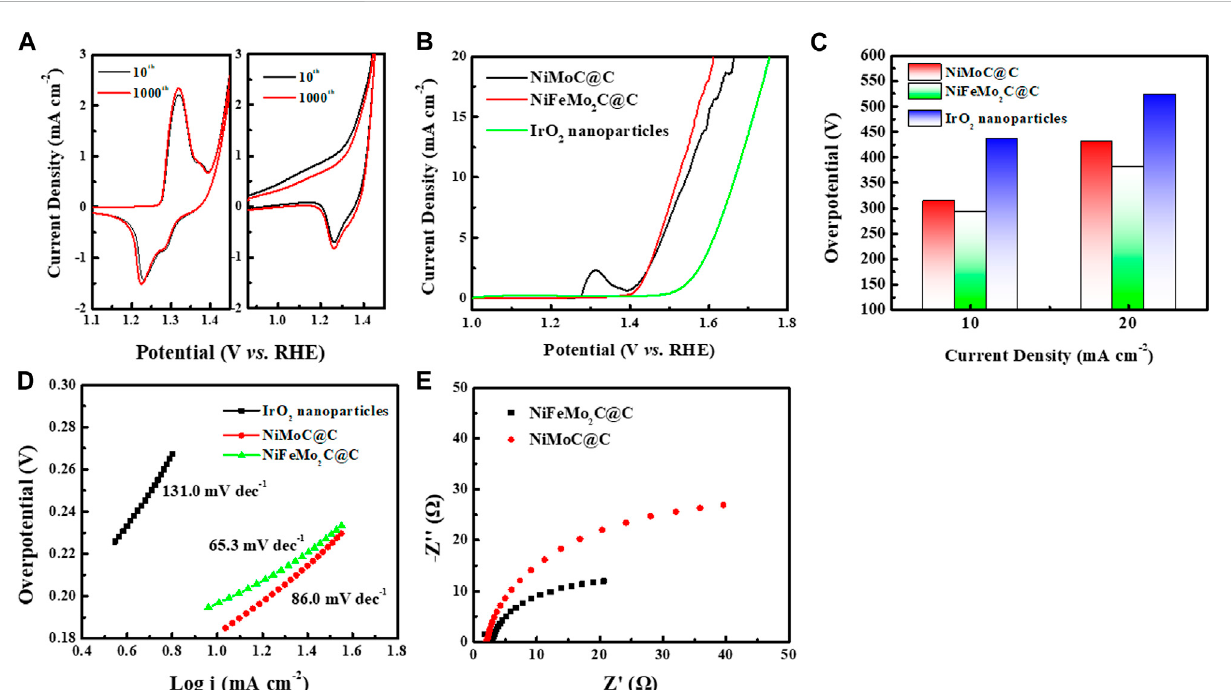
FIGURE 6 Electrochemical performance of as-prepared NiMoC@C, NiFeMo 2 C@C catalysts and commercial IrO 2 NPs toward the OER in 0.5 M KOH solution. (A) CVcurvesof10thand1000thcyclesofNiMoC@C,NiFeMo 2 C@Catascanrateof5 mV/s. (B) iR-compensatedLSVcurvesofNiMoC@C,NiFeMo 2 C@C catalysts and commercial IrO 2 NPs at a scan rate of 5 mV/s. (C) Summary of overpotential at j = 10 mA cm -2 and 20 mA cm -2 . (D) Tafel plots determined from the LSV curves. (E) EIS measurements at a constant potential of 1.544 V and 1.522 V vs. RHE for NiMoC@C, NiFeMo 2 C@C